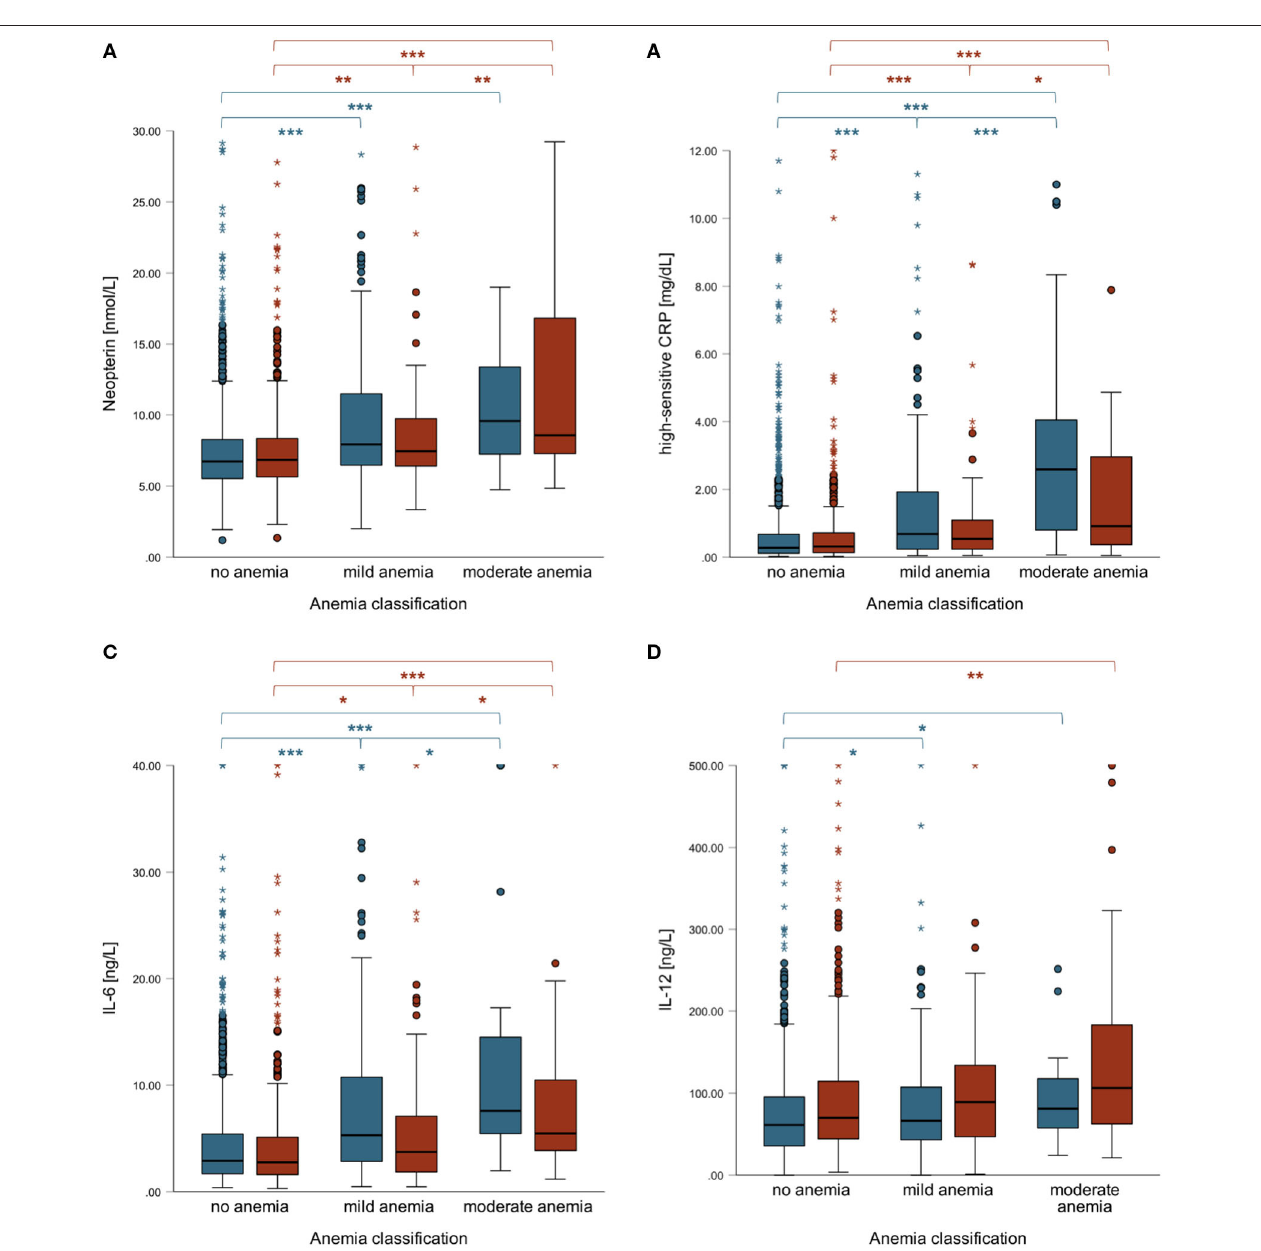
FIGURE 2 | Boxplots of neopterin (A) , hsCRP (B) , IL-6 (C) and IL-12 levels (D) in men (blue) and women (red) according to anemia severity. Men with mild or moderate anemia had significantly higher IL-6 levels compared to women with mild ( p = 0.007) or moderate anemia ( p = 0.060). *** p < 0.001, ** p < 0.01, * p <